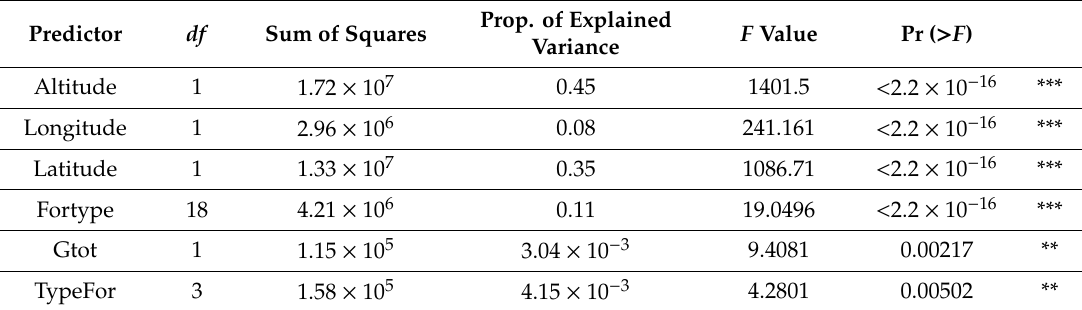
Table 3. Results of linear model function on the INFC 2005 domain. In this table, the variable fortype indicates the forest type category (i.e., beech forest, silver fir forest, etc.), the Gtot variable indicates the total basal area in m 2 and finally, the variable TypeFor considered the typology of forest (if pure or mixed, this characteristic is established on the base of basal area of di ff erent species) and the forest tree species (if tree was coniferous or broadleaves). The statistical significance is expressed as follow: 0 ≤ *** < 0.001 ≤ ** <